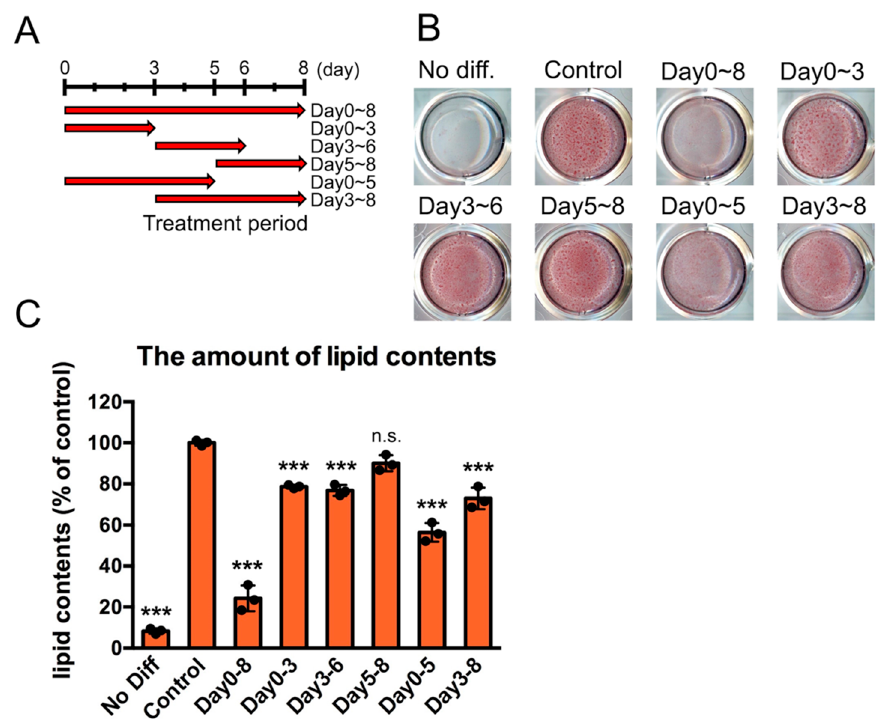
Figure 1. Inhibition of the early stage of adipocyte differentiation dramatically reduced lipid droplet formation and adipocyte differentiation. ( A ) experimental design. The PPM1D inhibitor was added at different stages of adipocyte differentiation. ( B ) Representative Oil red O-stained phase-contrast images of the time-dependent inhibition effect on adipocyte formation. 3T3-L1 cells were induced to differentiation upon stimulation by MDI, with the addition of SL-176 on the indicated days. The cells were fixed and stained with Oil red O. ( C ) Absorbance of Oil Red O extract was measured at 490 nm. Data are presented as the mean ± S.D. values and were obtained from three independent samples in each condition. Significance was analyzed by using one-way ANOVA with a post hoc Tukey’s multiple-comparison test. *** p < 0.001, n.s., not statistically significant compared with the